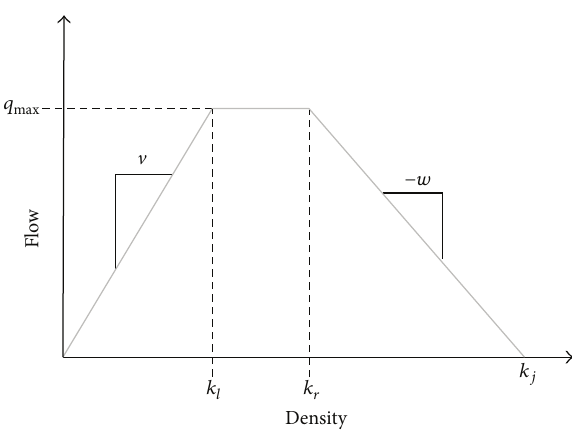
Figure 4: The trapezoidal fundamental